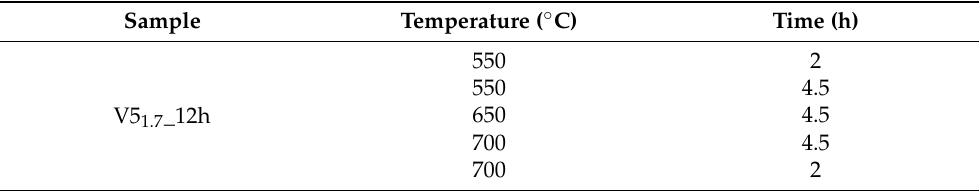
Table 2. Annealing at different temperatures and times for the conversion of VO 2 (B) to VO 2 (M1).